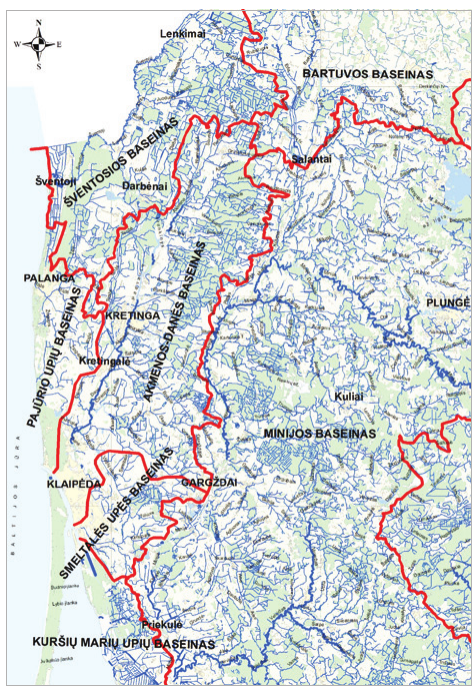
Fig. 1. River basins of Western